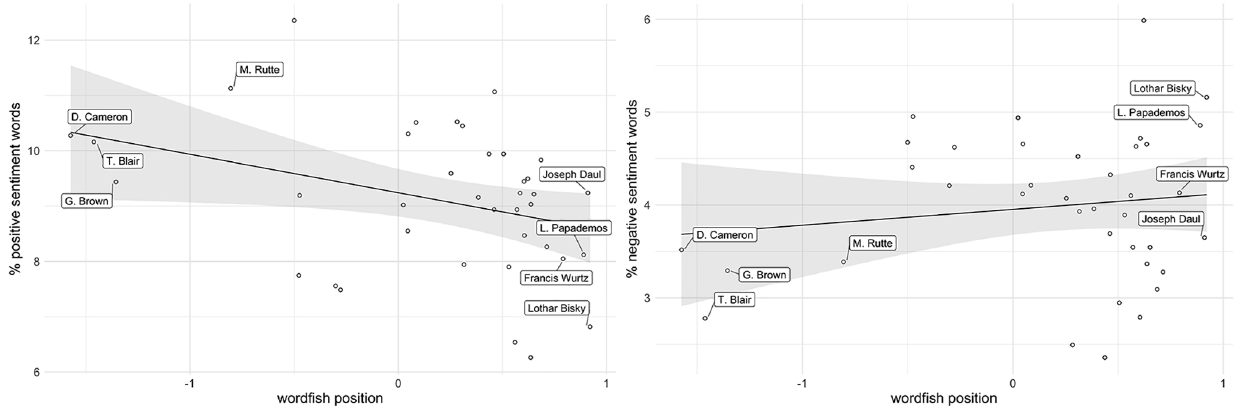
Figure 4. Use of sentiment and estimated Wordfish positions of speeches by politicians in the European Union. Note. These scatterplots denote the average use of negative sentiment (left) and average use of positive sentiment (right) over the range of the estimated average Wordfish position of heads of government and MEP group leaders. It shows that Wordfish scores and the use of positive sentiment are correlated with each